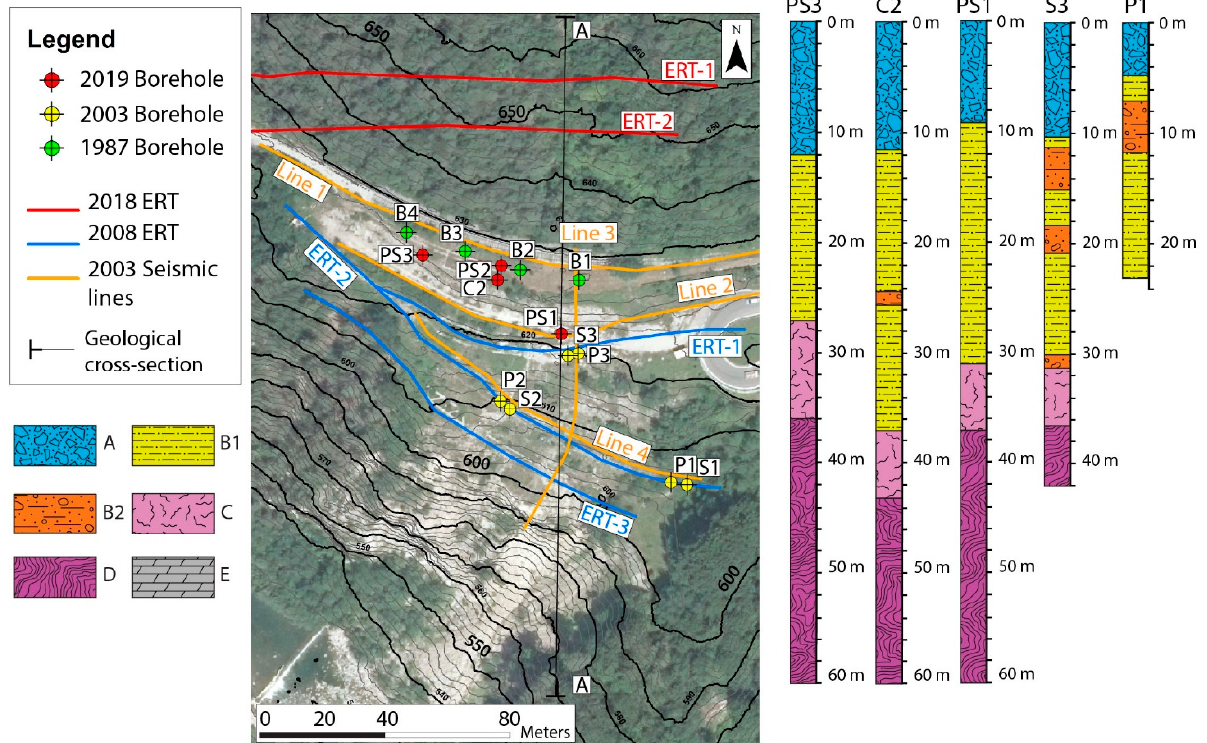
Figure 2. Boreholes and geophysical investigations performed on the landslide area [34–37]. The stratigraphy of the site is derived from field surveys. The different geological units are reported in the stratigraphic log: sandy gravel deposits (Layer A); debris flow deposits in its silty-clay level (Layer B1) and fine matrix sand and gravel level (Layer B2); the bedrock is represented by the fractured gypsum layer (Layer C) and by the anhydrite–gypsum rock mass (Layer D); dolomitic bedrock (Layer E) [36].